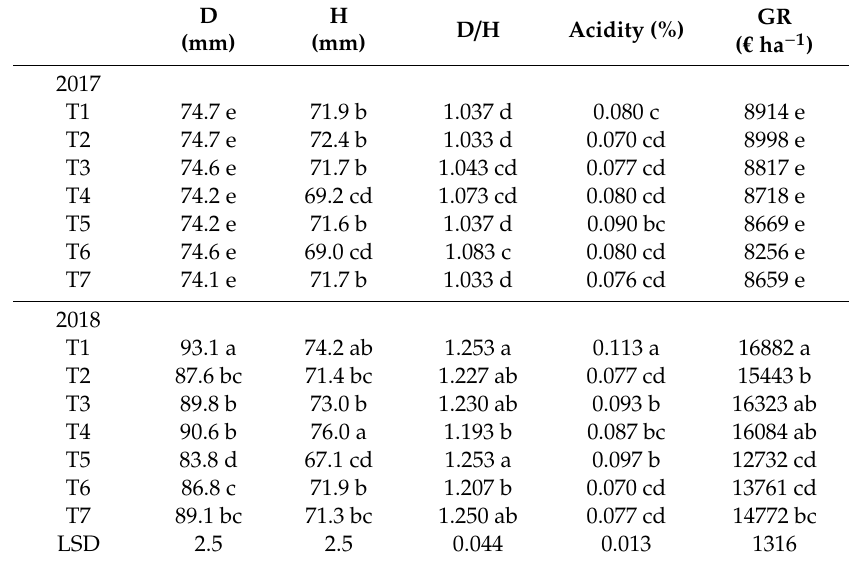
Table 7. Growing season–irrigation strategy interaction for bulb characteristics: size (diameter (D) and height (H), shape (D / H)), acidity, and gross revenue